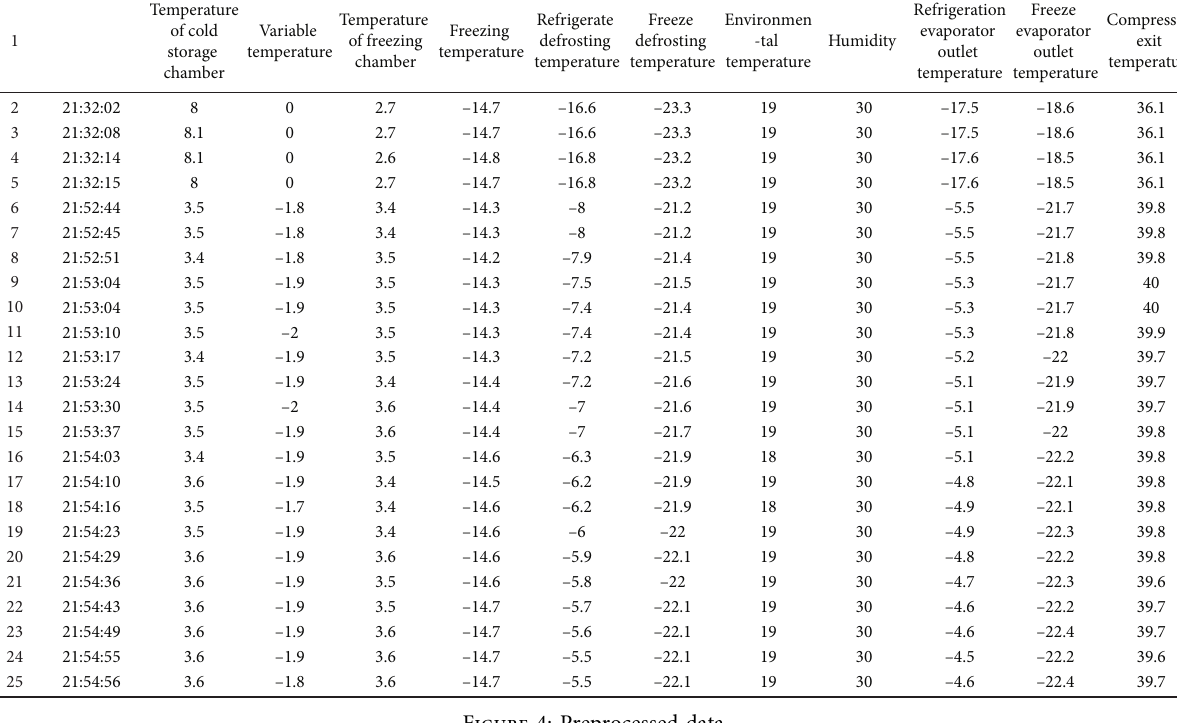
Figure 4: Preprocessed data.